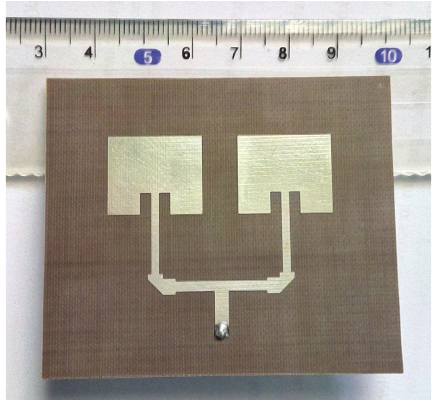
Figure 17: Photograph of the two-element array.